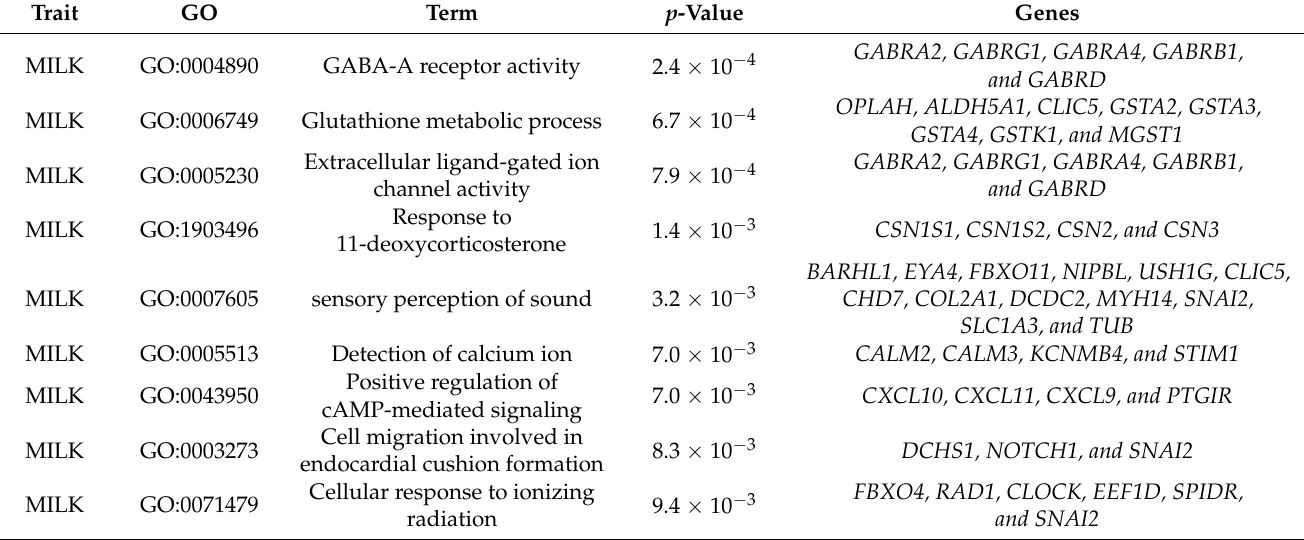
Figure 3. Gene interaction network for the central genes associated with lactation persistency, milk yield, fat yield, fat percentage, protein yield, and protein percentage in North American Holstein cattle. Table 4. Most significantly enriched gene ontology (GO) terms of candidate genes for milk yield (MILK), fat yield (FAT), and fat percentage (FAT%) in North American Holstein